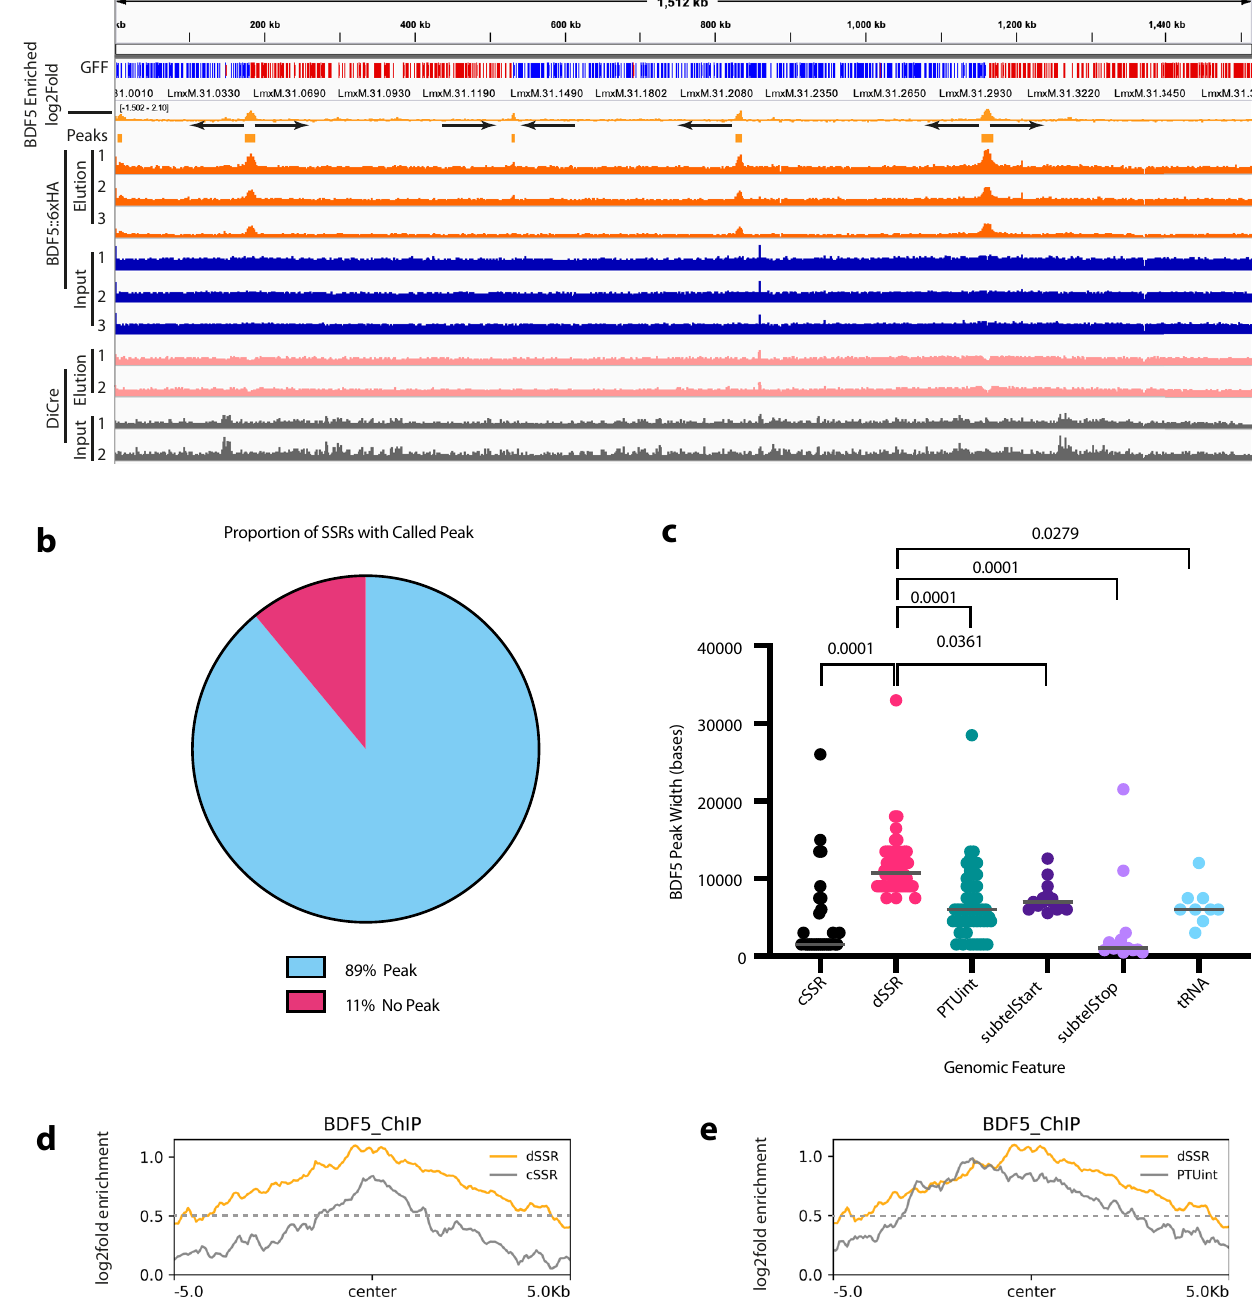
Fig. 4 ChIP-seq analysis of BDF5 distribution on chromatin. a IGV genome browser view using chromosome 31 as an example, indicating the genes in polycistronic transcription units (colour and arrow coded by direction), the read depth for input and eluted sample of the ChIP-seq of BDF5 − / + fl x ( N = 3) and the enrichment of DNA associated with BDF5::6xHA on a log2 fold scale, GFF (gene feature fi le) indicates gene CDS coloured by strand (red + , blue-). Control ChIP-seqs were performed for the DiCre strain which does not contain a HA-tagged protein and input (grey tracks) and eluted (pink tracks) samples are represented below ( N = 2). Peaks were de fi ned as regions being >0.5 log2fold enriched in the elution versus input. b Pie chart indicating the proportion of SSRs with a BDF5-enriched peak. c BDF5 peak size at different genomic regions, cSSR (convergent strand switch region, n = 28), dSSR (divergent strand switch region, n = 54), PTUint (internal PTU peak, n = 52), subtelStart (subtelomeric peak consistent with PTU transcriptional start, n = 15), subtelStop (subtelomeric peak consistent with PTU transcriptional stop, n = 13), tRNA (tRNA gene located away from any of the other features, n = 9). Values above denote p-value from Kruskal – Wallace test to compare samples. d Metaplot of average BDF5 fold enrichment at dSSR ( n = 60) and cSSR ( n = 40) regions. e Metaplot of BDF5 average BDF5 fold enrichment at dSSR ( n = 60) and PTU internal peaks ( n =